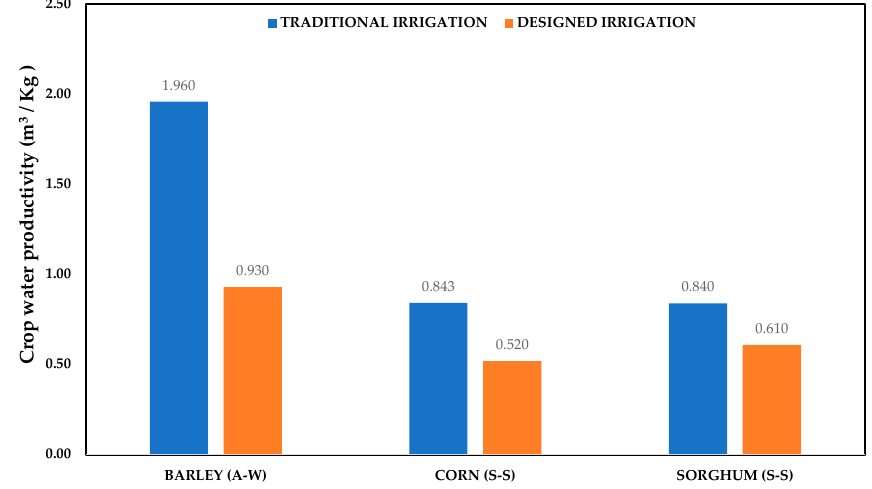
Figure 7. The water productivity obtained by cycle.